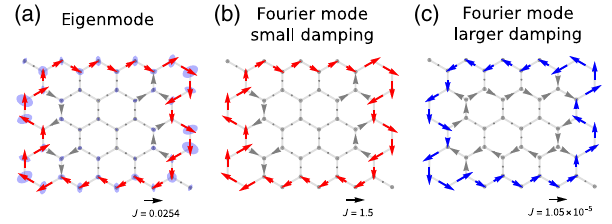
FIG. 6. Comparison between a boundary-localized eigenmode of the undamped isolated network and the Fourier modes of the damped network at the same frequency. First-order dynamics (by setting m ¼ 0 ) are used. Numerical calculations are performed with all other parameters set to 1. (a) Eigenmode of undamped gyroscopic system. For the frequency chosen, the eigenmode is localized on the boundary. Blue disks represent the orbit of particles. (b) The Fourier mode of the damped variant of our model at small γ ( γ ¼ 0 . 001 ) resembles the eigenmode. (c) The Fourier mode at larger γ ( γ ¼ 1 ) is no longer close to the eigenmode.